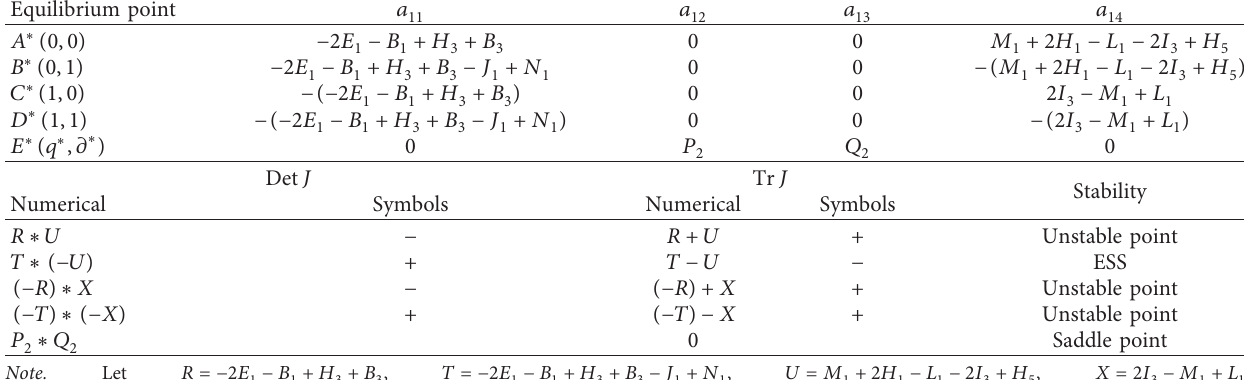
Table 4: Analysis of the stability of the equilibrium point between the local government and farmers. Equilibrium point a